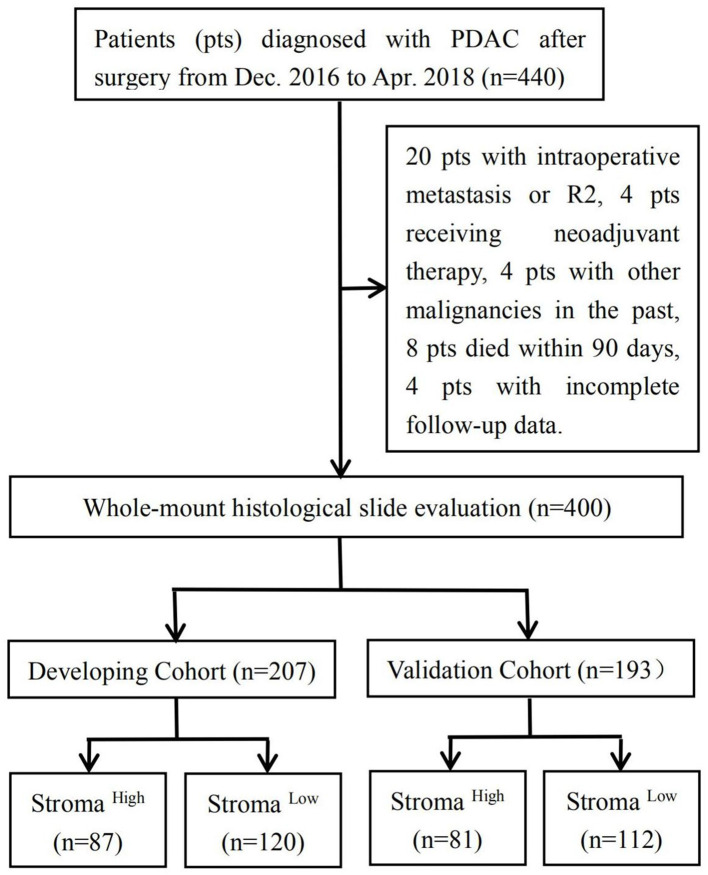
Flowchart depicting patient selection in the study.